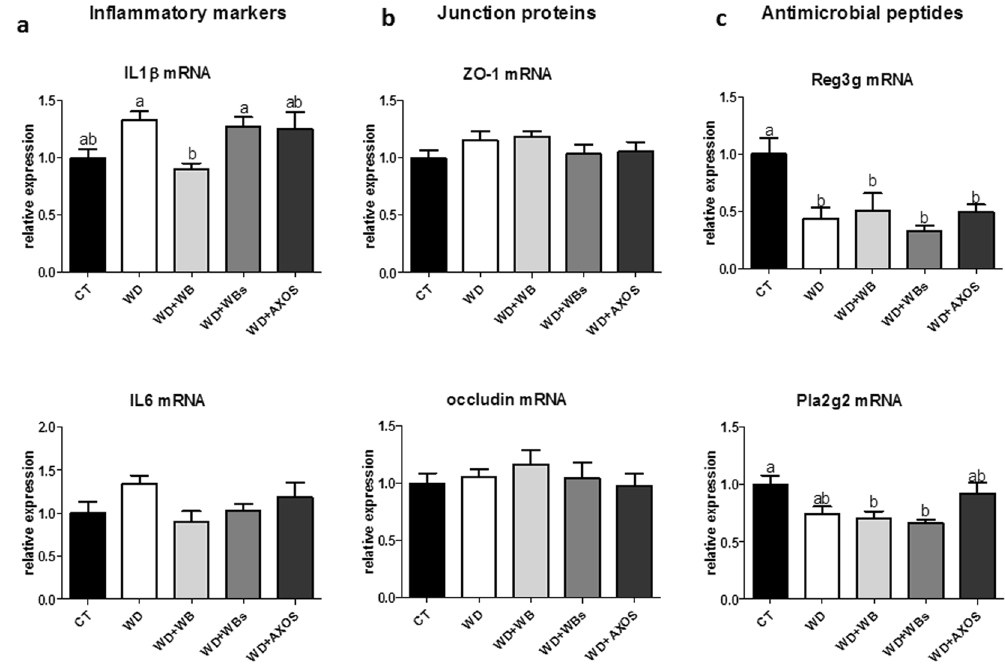
Figure 4. Impact of the three cereal fractions on gut barrier function. Expression of inflammatory markers ( a ), expression of junction proteins ( b ) and expression of secreting antimicrobial peptides ( c ) in the ileum of mice fed a control diet (CT), a western diet (WD), a WD supplemented with 5% of wheat bran (WD + WB), a WD supplemented with 5% of wheat bran with reduced particle size (WD + WBs) or a WD supplemented with 5% of AXOS (WD + AXOS) for 8 weeks. Results are expressed as mean ± SEM (n = 7–9). Data with different superscript letters are significantly different at p < 0.05